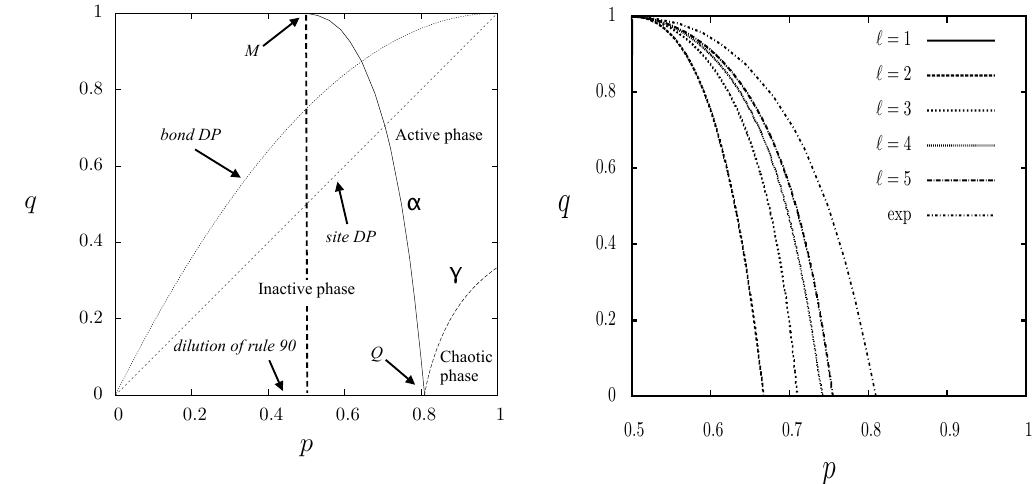
Figure 5. ( Left ) The phase diagram of the Domany–Kinkel model, where α marks the density transition and γ the damage transition. The dashed line marks the transition line for the simplest mean-field approximation. ( Right ) Several improved mean-field approximations. Figure from [61].